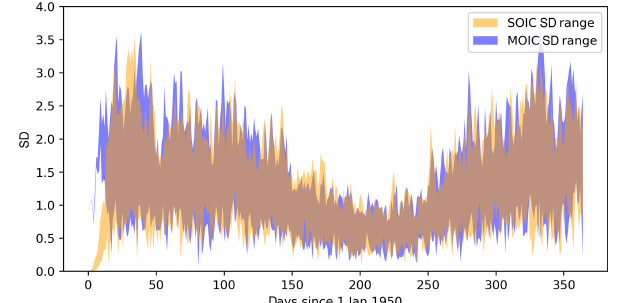
Figure 1. Inter-member standard deviation of a daily NAO index in CanESM2-LE starting on 1 January 1950 as a function of time. The inter-member standard deviation (SD) is derived from 10 groups of five members with the same ocean initial conditions (SOICs) and 10 groups of five members with mixed ocean initial conditions (MOICs, following an approach in Leduc et al.,